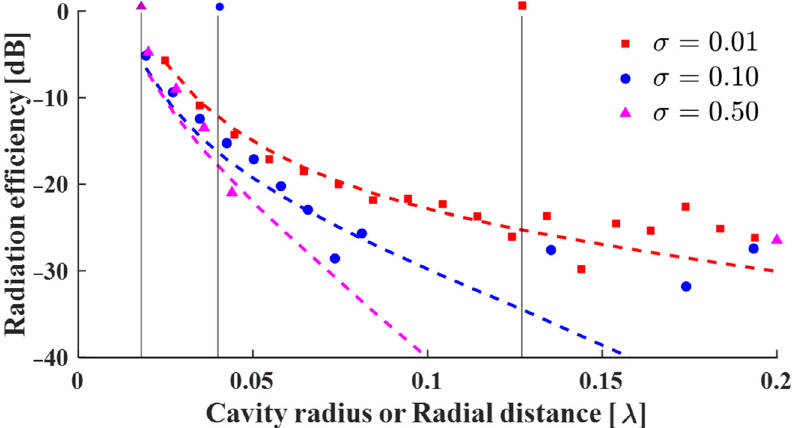
Figure 6. The radiation efficiency η WR versus cavity radius r w with changes in the conductivity and η MR versus radial distance d r is marked with a dash for the same color line. The radian length r l (cid:48) is marked with black lines.